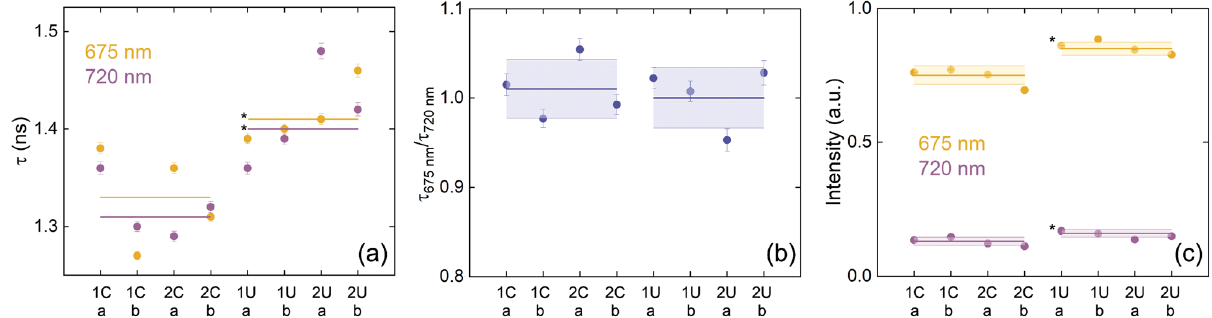
Figure 3. Lifetimes extracted for the ( a ) 675-nm peak and 720-nm peak; ( b ) the ratio of the lifetimes used to identify preferential disruption to PSII or PSI during stress; ( c ) time-integrated intensity for both peaks and all exposure conditions. The individual error bars correspond to the uncertainty in the exponential fit for ( a ), error propagated for the ratio of the lifetimes for ( b ), and error associated with the signal intensity assuming Poisson statistics for ( c ). The lines across the four data points represent the mean, while the shaded areas represent twice the standard error for four data points per condition. The control and U-exposed samples have the following means and twice the standard error, respectively: ( a ) at 675 nm – 1.33±0.04 and 1.41±0.04; at 720 nm – 1.31±0.04 and 1.40±0.06; ( b ) 1.01±0.04 and 1.00±0.04; ( c ) 0.75±0.04 at 675 nm, 0.13±0.02 at 720 nm and 0.85±0.02 at 675 nm, 0.16±0.02 at 720 nm. The asterisks (*) next to the mean uranium data denote that that t-test determined that they are statistically different from the mean of the control